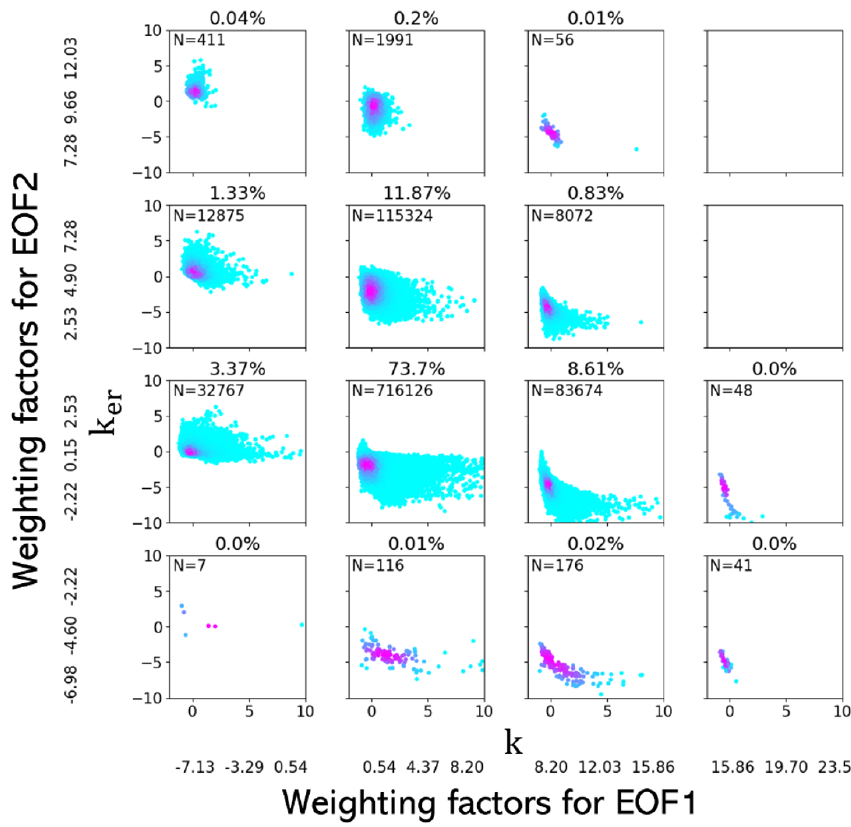
Figure 11. The density scatterplot between k and that defined by r τ = k er τ + r 0 .